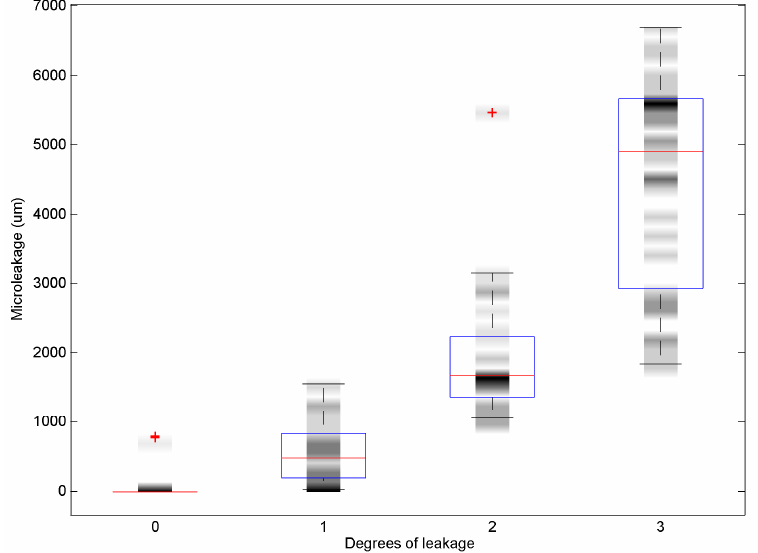
Figure 3. Distribution of microleakage in micrometers vs degrees of leakage: 0—no leakage; 1—dye has seeped through half of the cavity wall (lengthwise); 2—dye has seeped through the full length of the cavity wall; 3—dye has seeped through the full length of the cavity wall and has reached the bottom of the cavity (the axial wall).